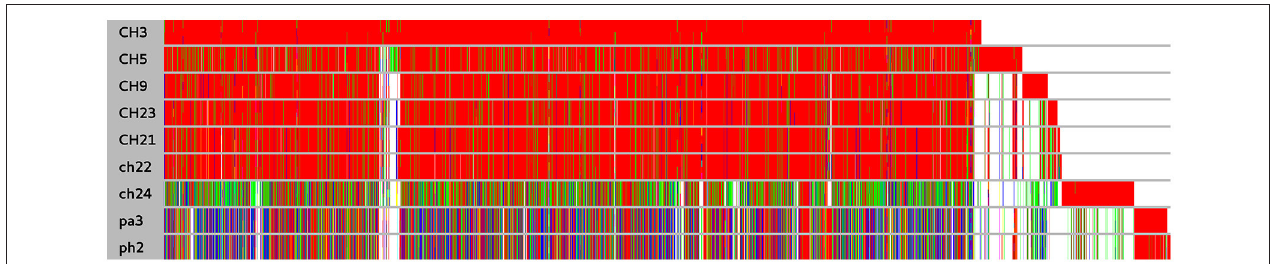
FIGURE 1 | Comparison of protein clusters among nine S. aureus strains. Clusters were obtained for annotated coding sequences at threshold of 90% similarity. Within a cluster identical sequences are denoted by the same color. White denotes the absence of an ortholog. Long white gaps at the end of the plot correspond to the absence of different mobile genetic elements such as plasmids. The cluster order is related to the order of coding sequence occurrence in the genome of ED98.